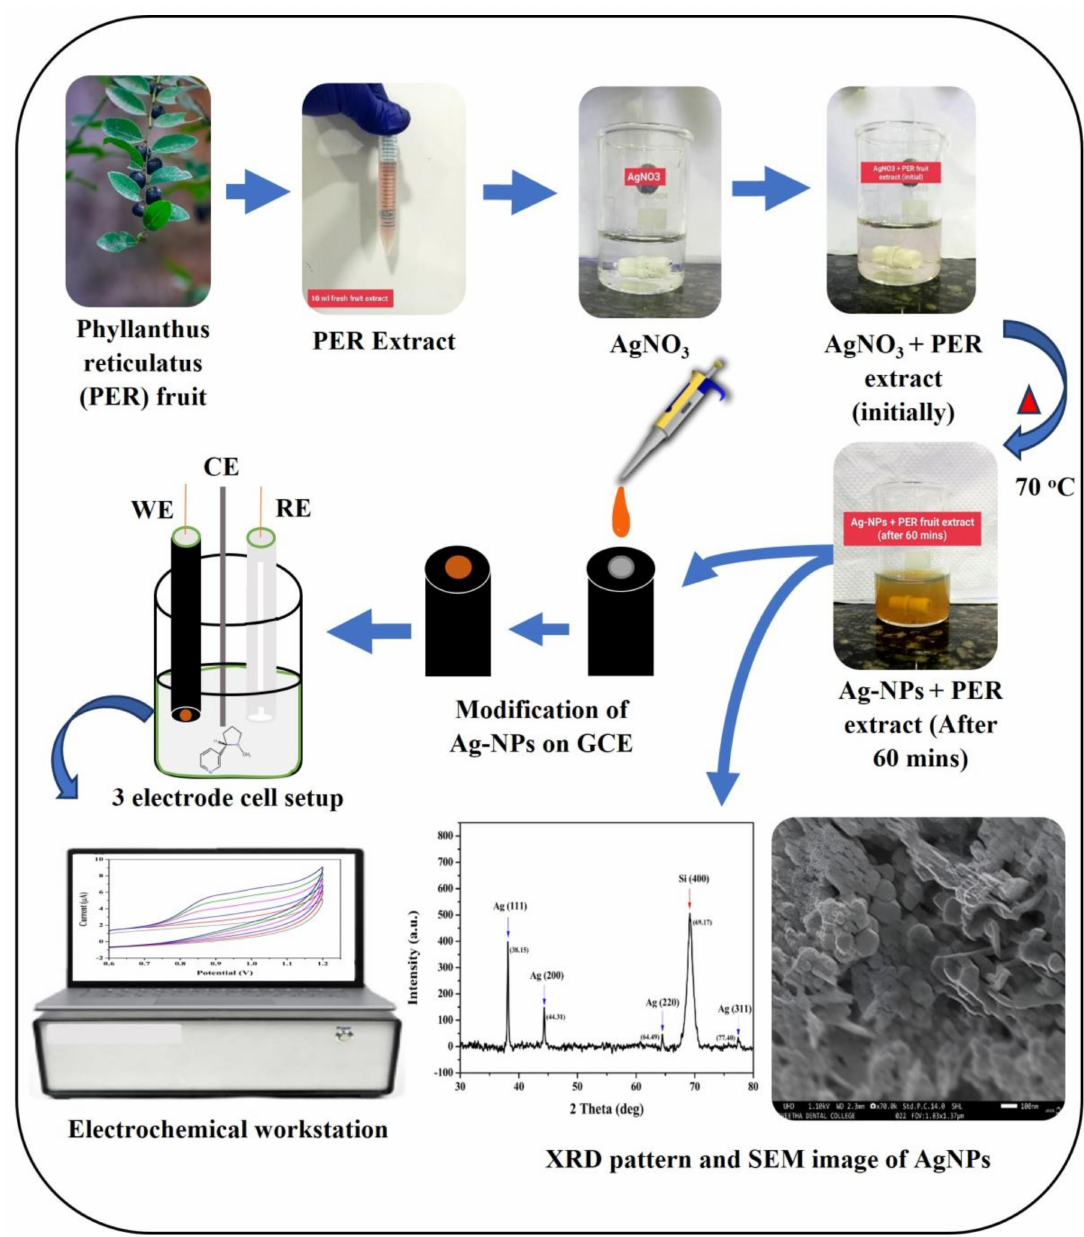
Figure 2. Schematic representation of green synthesis of Ag-NPs for electrochemical detection of